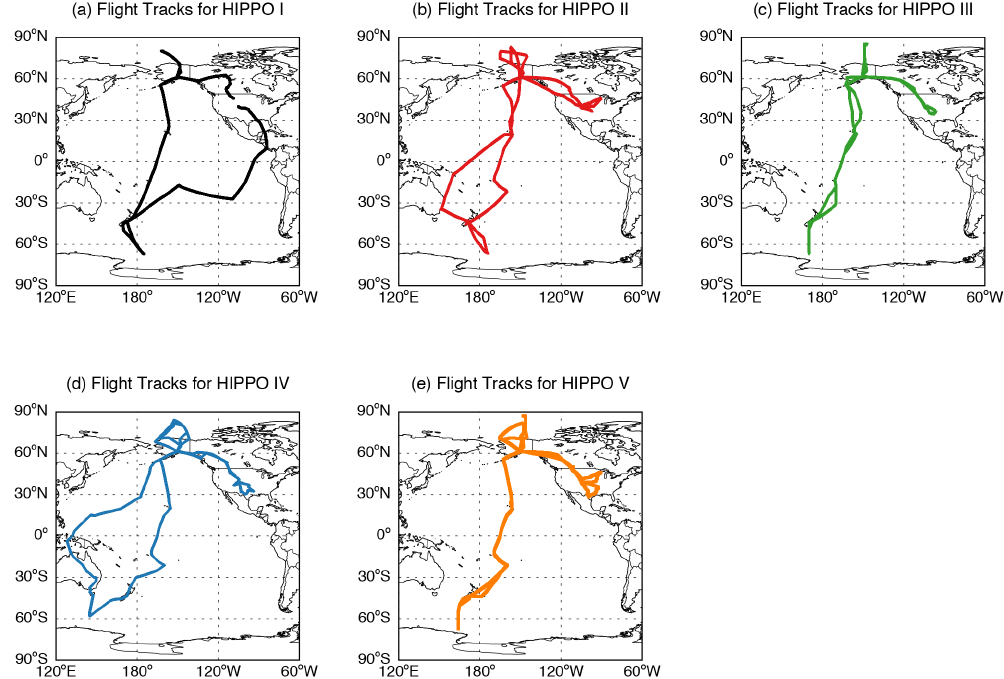
Figure 1. Flight tracks for HIPPO campaigns I through